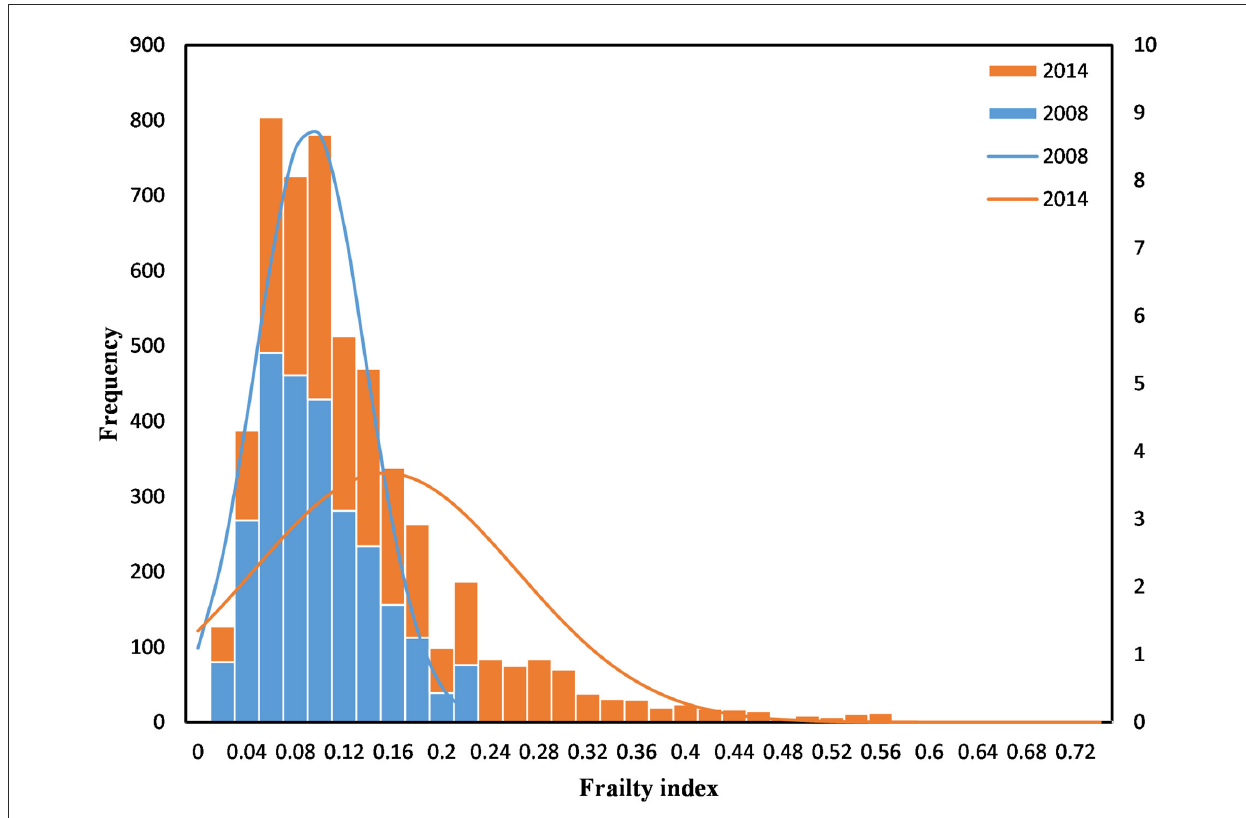
FIGURE2 Histogram of the frailty